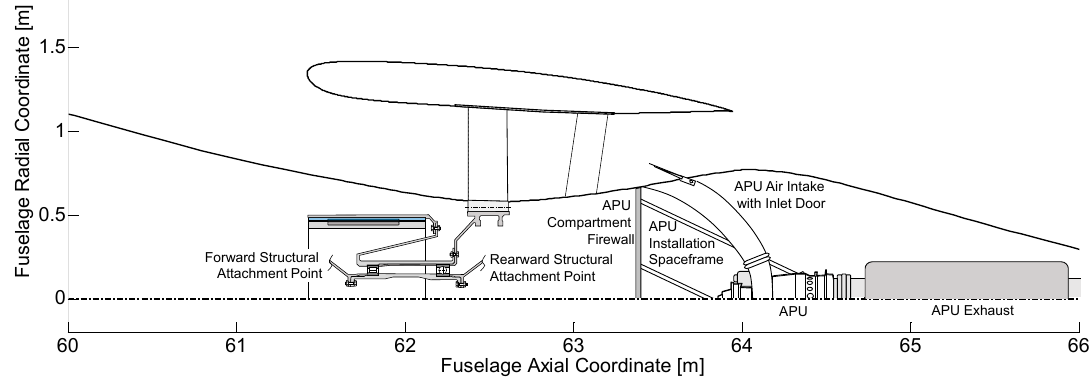
Figure 20. Concept sketch of the aft-fuselage power plant integration.